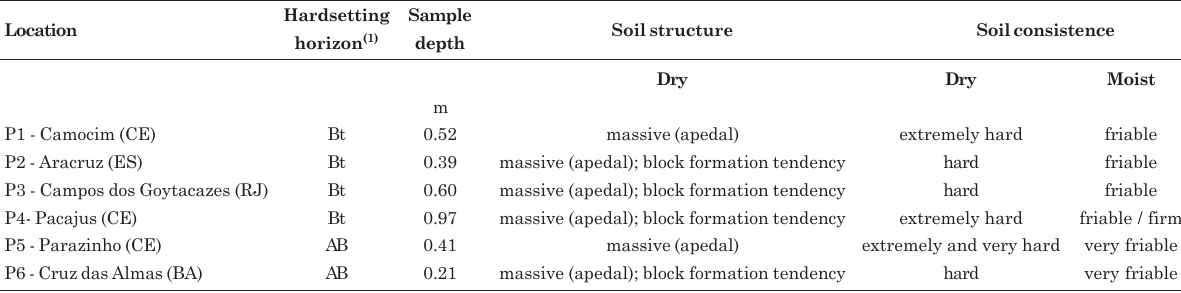
(1) Bt: horizon with alluvial clay accumulation, AB: transition horizons.